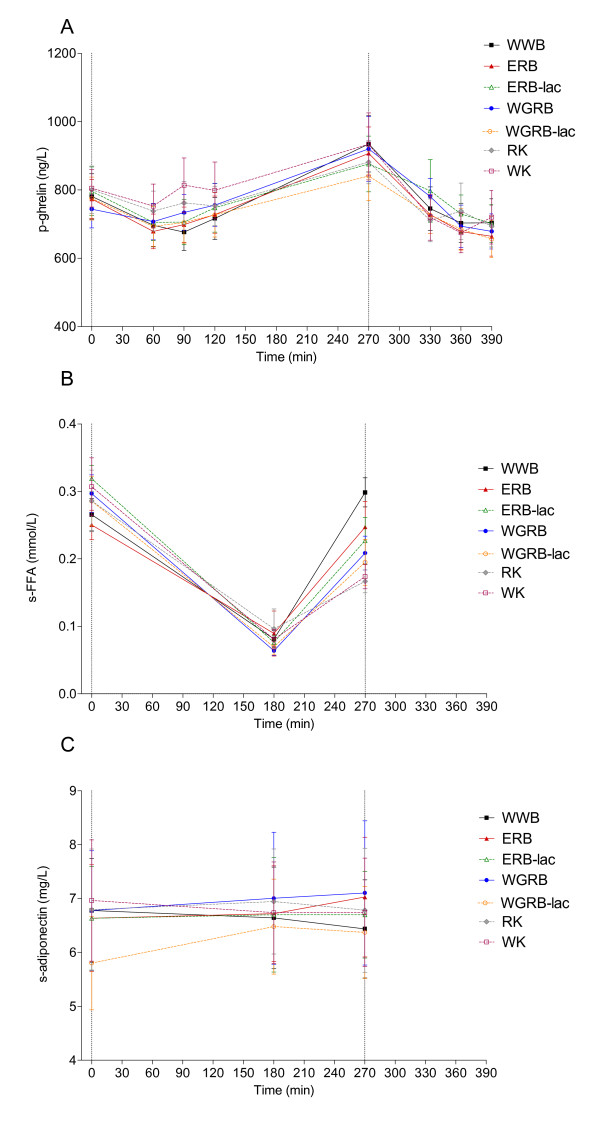
Postprandial change in ghrelin, (A), FFA (B) and adiponectin (C). Values are means ± SEM, n = 10 (n = 9 for WGRB).